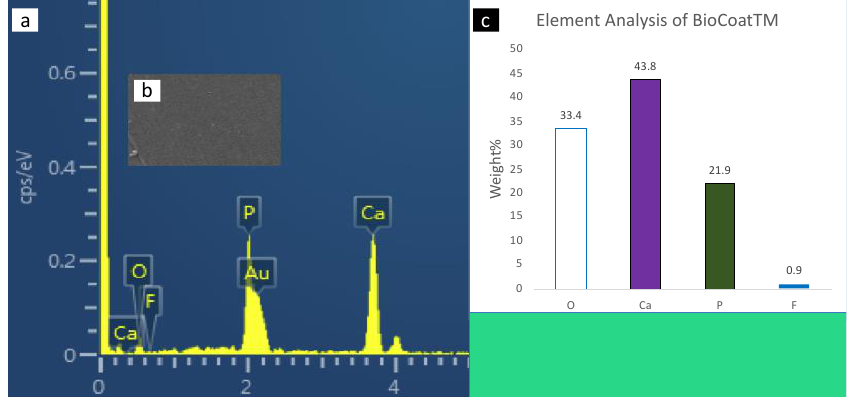
Figure 6. The SEM-EDX evaluation of the enamel samples under BioCoat: ( a ) the SEM-EDX spectrum shows the dominant elements; ( b ) SEM image of the area for which the EDX spectrum was acquired; ( c ) concentrations of elements in weight (weight percent) of the oxygen, calcium, phosphate and fluoride elements found in enamel surface under the sealants.